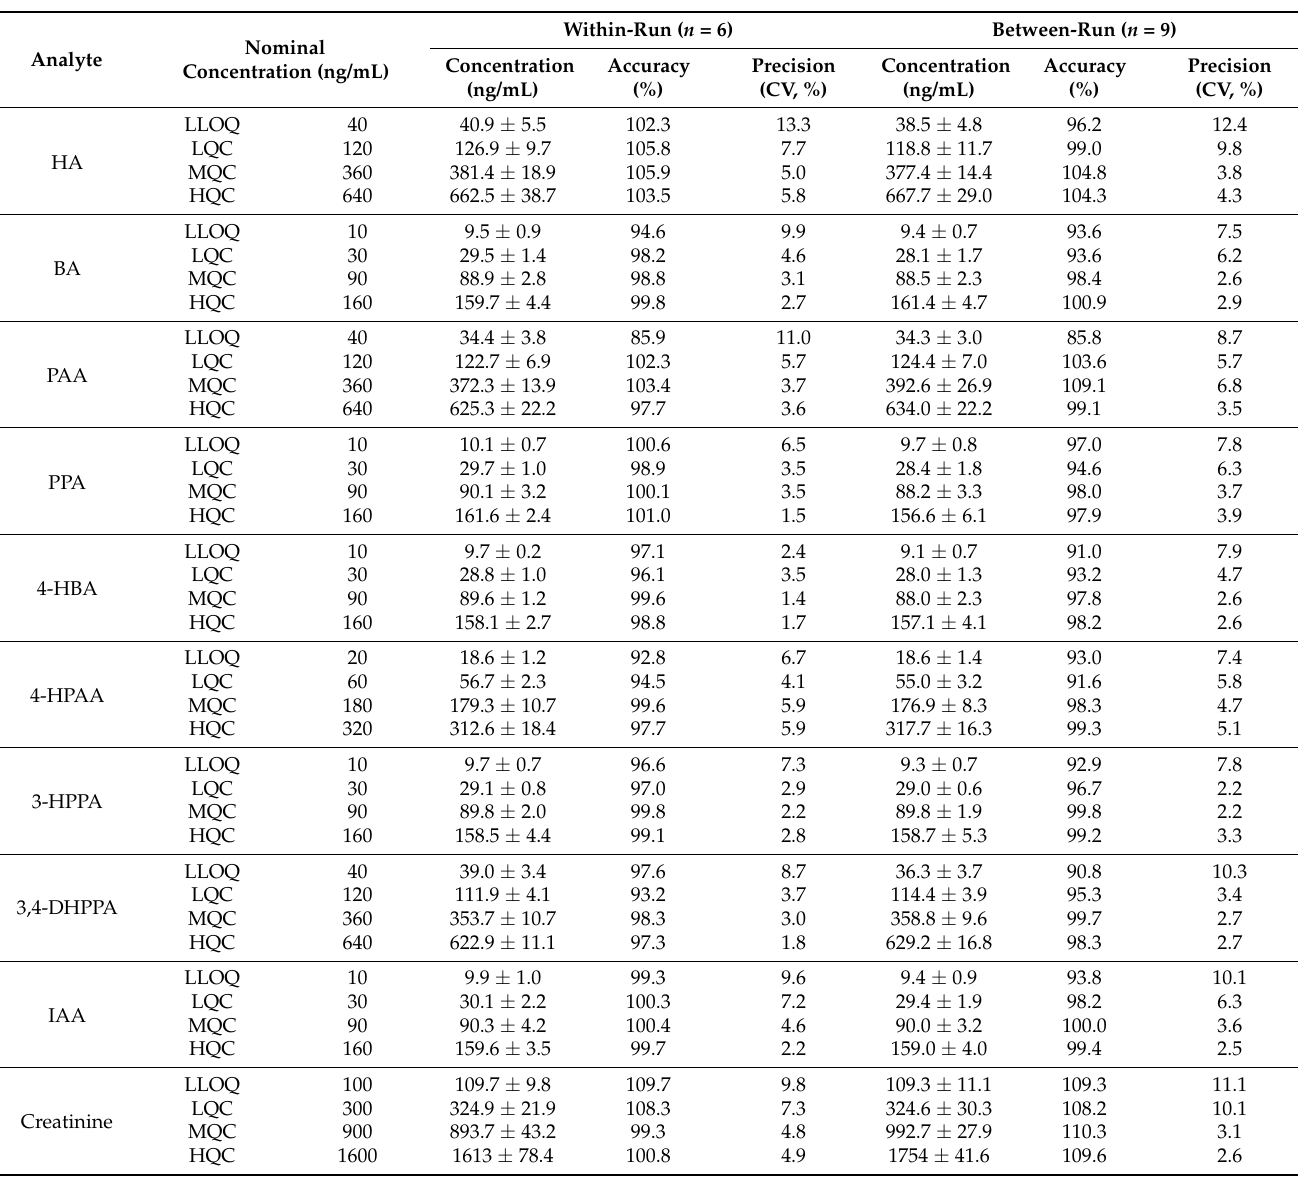
Table 2. Within-run and between-run accuracy and precision of nine organic acids and creatinine in human